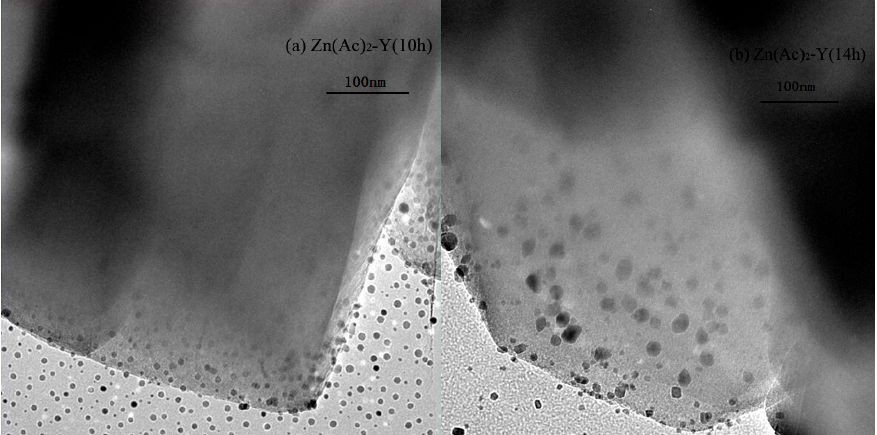
Figure 3. TEM images of adsorbents, ( a ) Zn(Ac) 2 -Y (10 h); ( b ) Zn(Ac) 2 -Y (14 h).